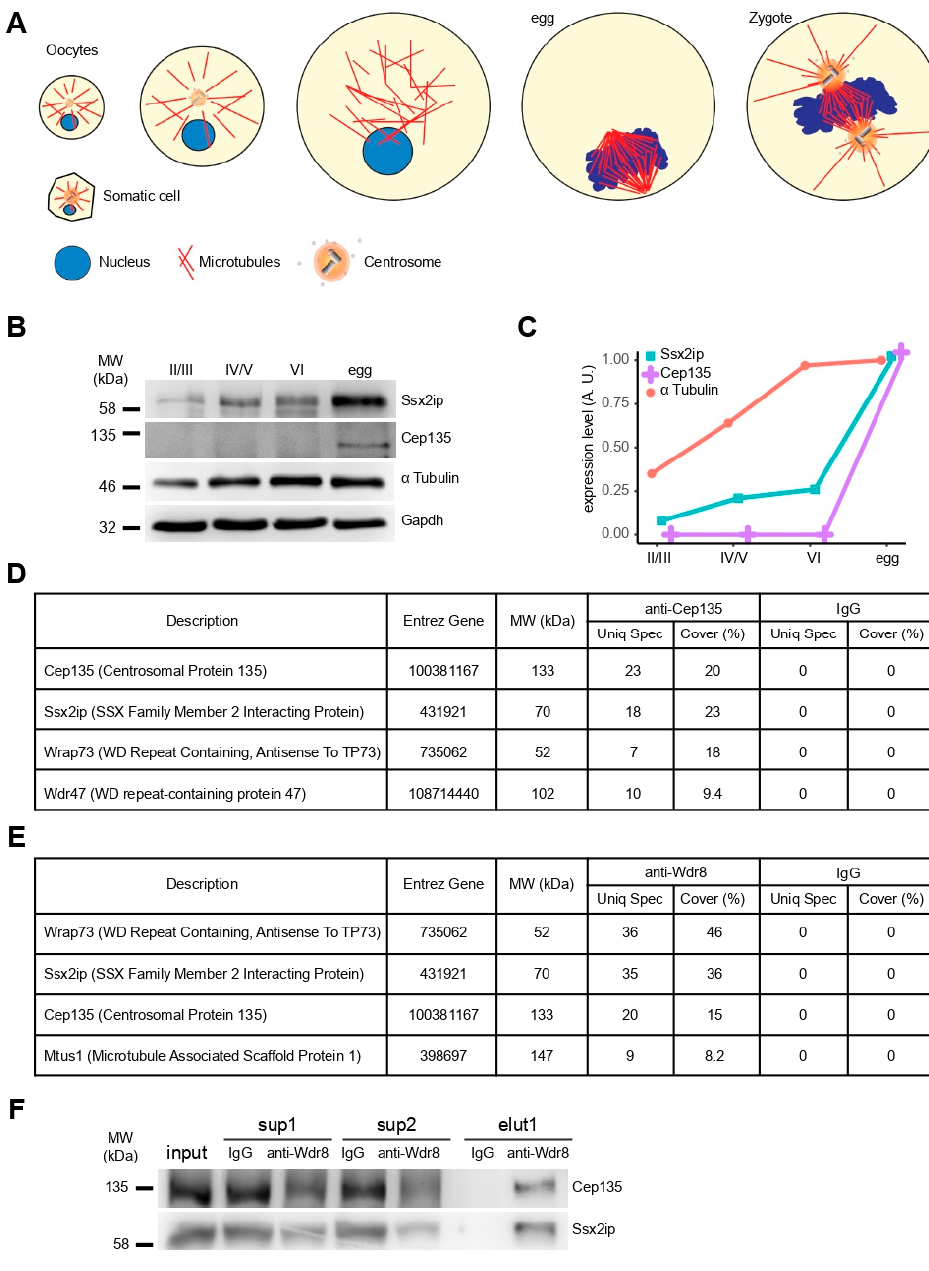
Figure 1. Interactome of Cep135, Wdr8, and Ssx2ip in Xenopus egg extracts. ( A ) Schematic drawing illustrating the state of centrosomes in somatic cells, developing oocytes, ovum (egg), and fertilized egg (zygote). ( B , C ) Immunoblotting ( B ) and corresponding quantification ( C ) of Ssx2ip, Cep135, and α -tubulin to evaluate protein expression at different Xenopus oocyte stages. The total amount of protein was controlled by glycerol aldehyde 3 phosphate dehydrogenase (Gapdh). ( D , E ) Identification of proteins specifically precipitated with antibodies against Cep135 ( D ) or Wdr8 ( E ) using tandem mass spectrometry. The list shows only a fraction of proteins identified. ( F ) Immunoprecipitations using antibodies against Wdr8 (elu1 Wdr8, elu1 IgG: control) analyzed by immunoblotting of Cep135 and Ssx2ip. Input (total extract) and supernatants (sup1/sup2) of extracts after IP are shown from two sequential precipitations.